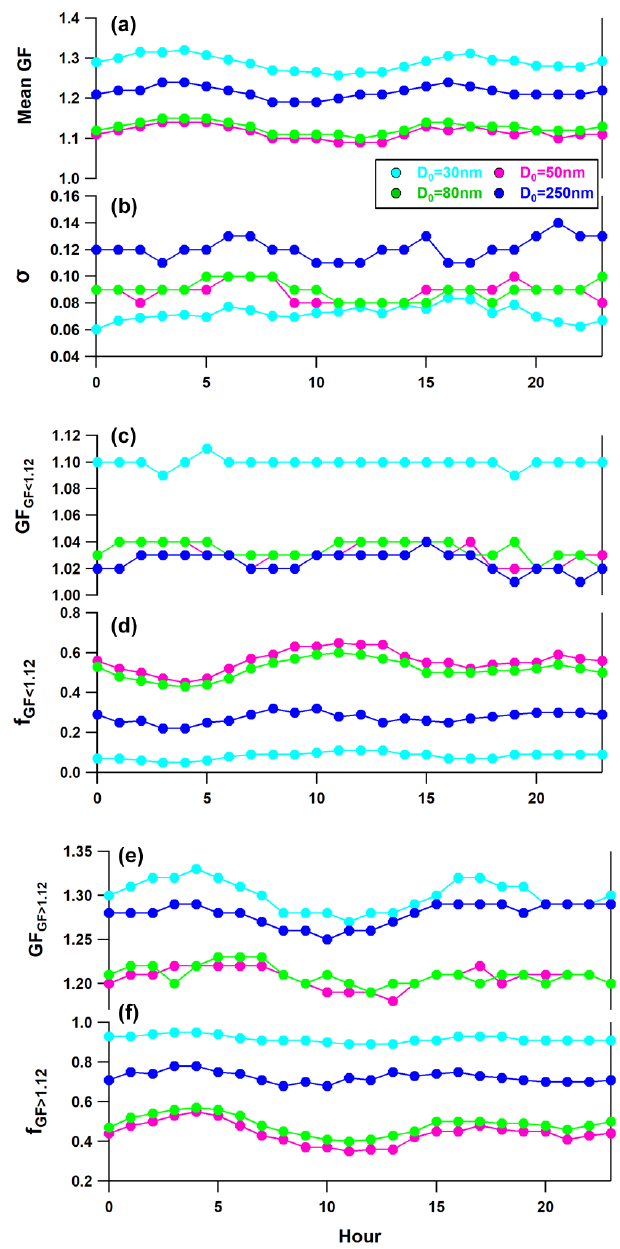
Figure 7. Diurnal variation in (a) mean GF, measured at RH = 90%, (b) standard deviation of the mean GF, (c) GF of non- or slightly hygroscopic particles, (d) the number fraction of non- or slightly hygroscopic particles, (e) GF of moderately hygroscopic particles, and (f) the number fraction of moderately hygroscopic